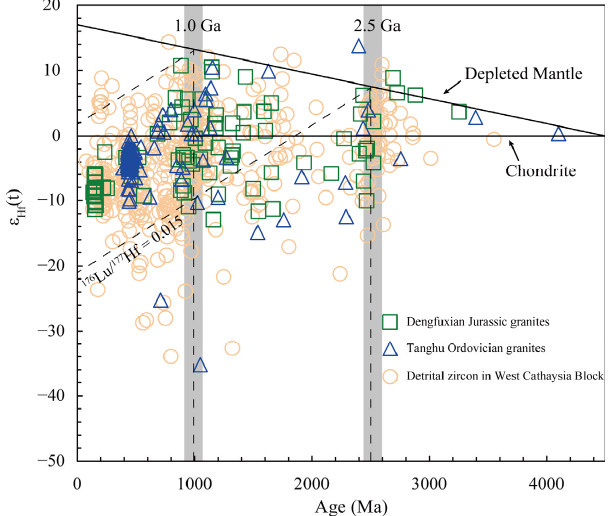
Figure 9. Zircon ε Hf (t) values versus U ‐ Pb ages diagram. The data of the detrital zircons in the west Cathaysia Block are from [4,29,81,82], respectively.